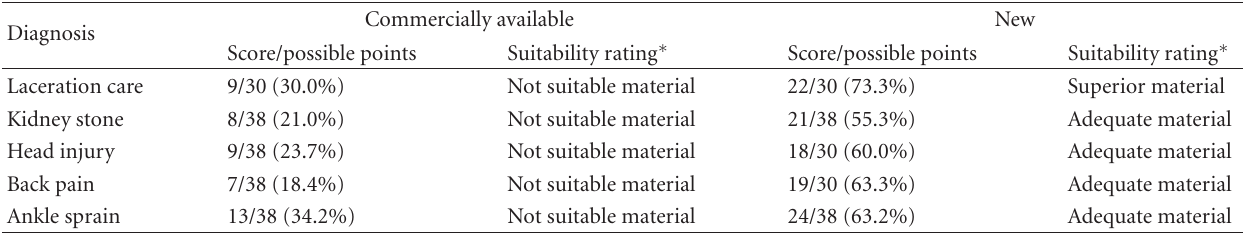
Table 1: Suitability Assessment of Materials (SAM) #